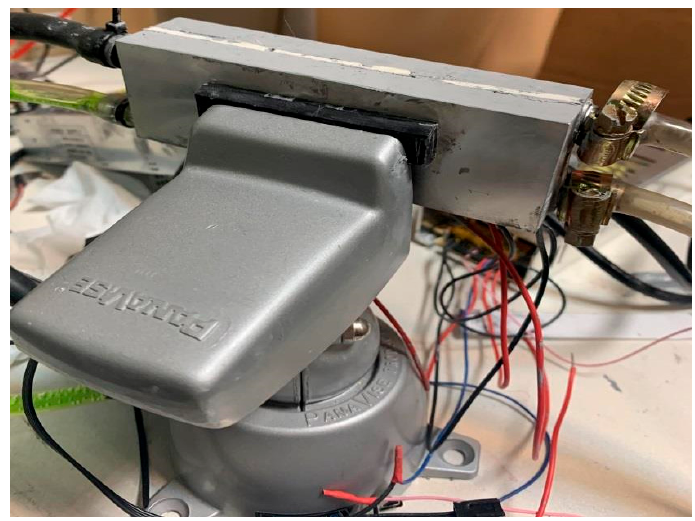
Figure 3. The aluminum block is attached to the thermoelectric modules from one side only.